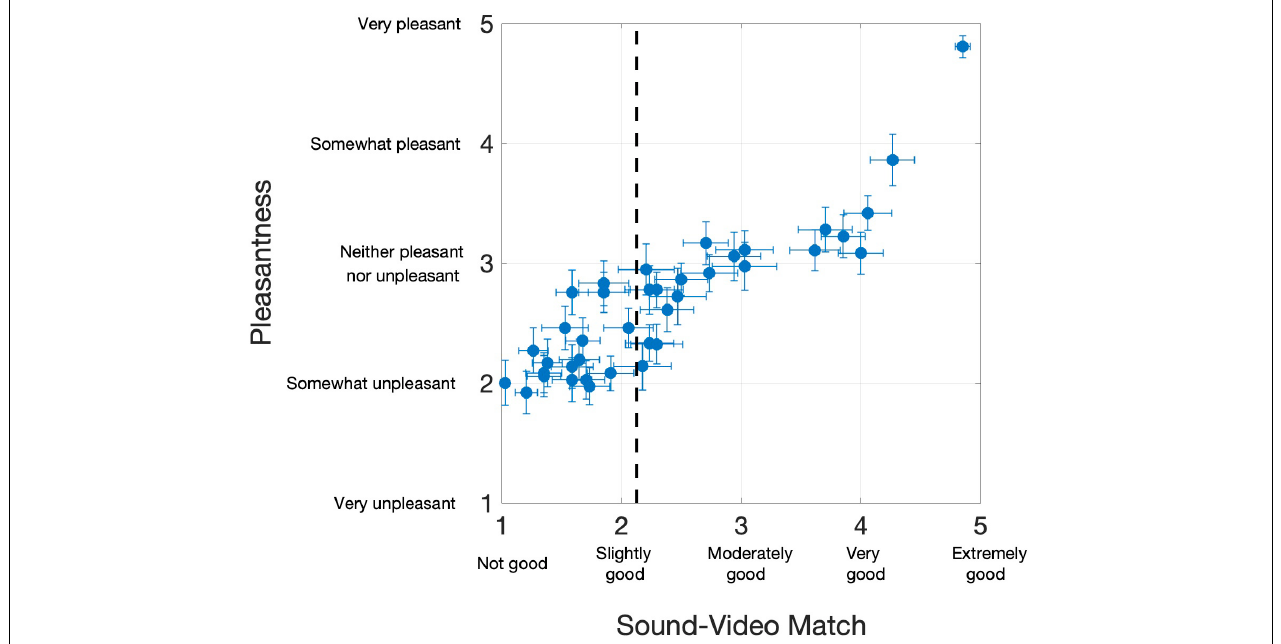
FIGURE 1 | Results from 34 participants in Study 2. Each dot represents a PAVS video. The x-position shows the mean sound-video match rating, and y-position shows the mean pleasantness rating. Horizontal and vertical error bars represent one standard error from the mean on the two scales, respectively. The dotted line represents the sound-video match cut-off we used to select the top 20 stimuli for Study